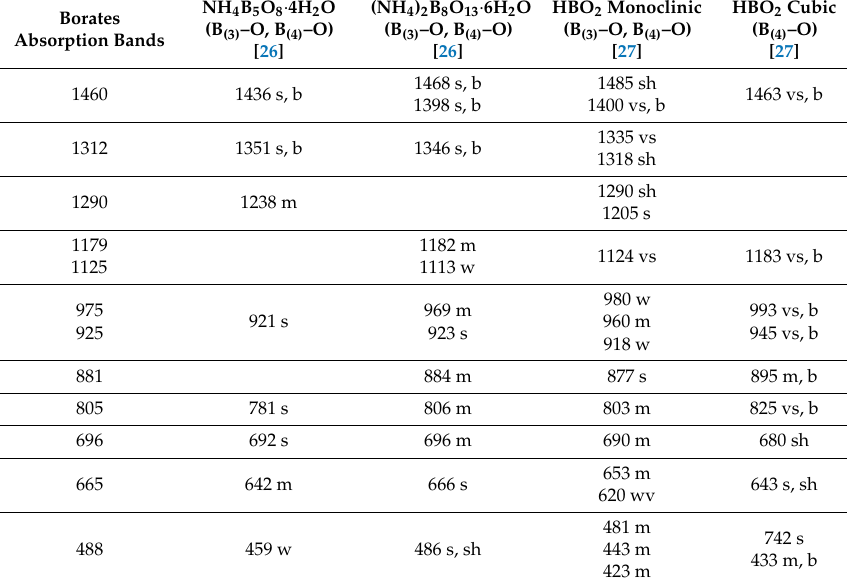
Table 1. Comparison of the absorption bands (in cm − 1 ) of the borate anions forming in the interaction of NH 3 BH 3 with H 2 O with the spectra of the model compounds.